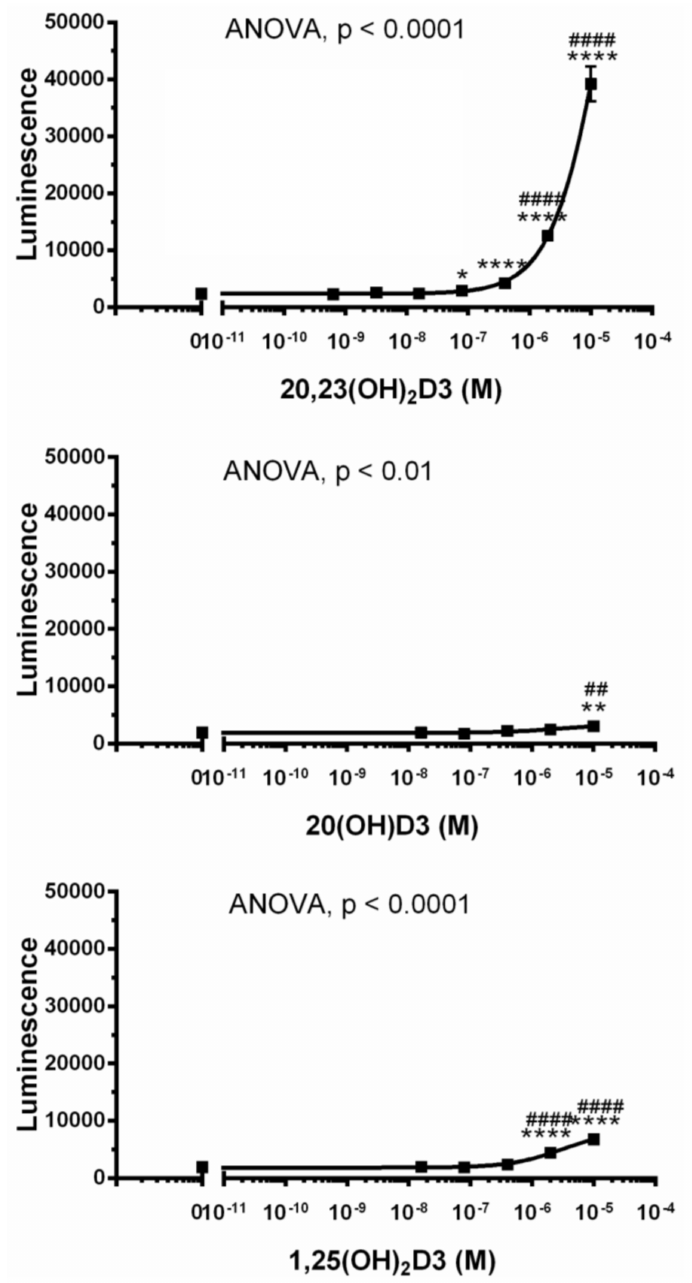
Figure 6. Stimulation of AhR activity by 20(OH)D3, 22,23(OH) 2 D3, and 1,25(OH) 2 D3. The assays for 22,23(OH) 2 D3 were performed in quadruplicate, while for 20(OH)D3 and 1,25(OH) 2 D3 in triplicate. Data represent means ± SD where * p < 0.05, ** p < 0.01 and **** p < 0.0001 at student t -test; ## p < 0.01 and #### p < 0.0001 at one-way ANOVA